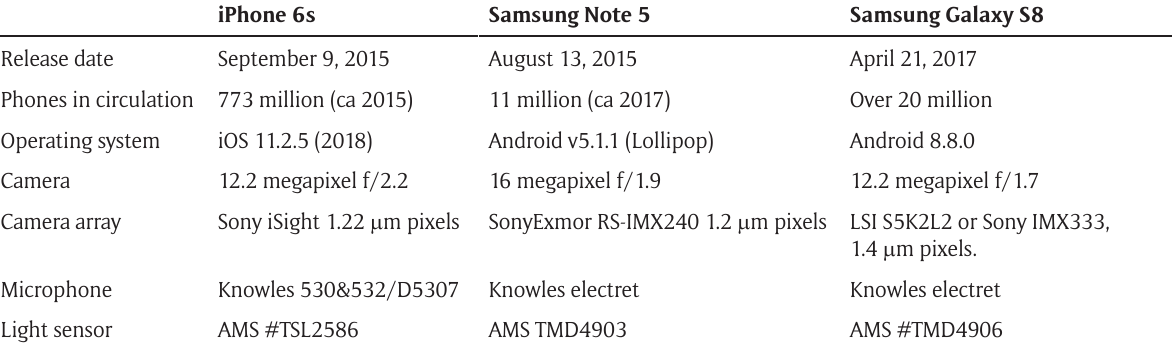
Table 1: Manufacturing date, usage, and light and sound sensor data for the iPhone 6S, Samsung Note 5, and Samsung Galaxy